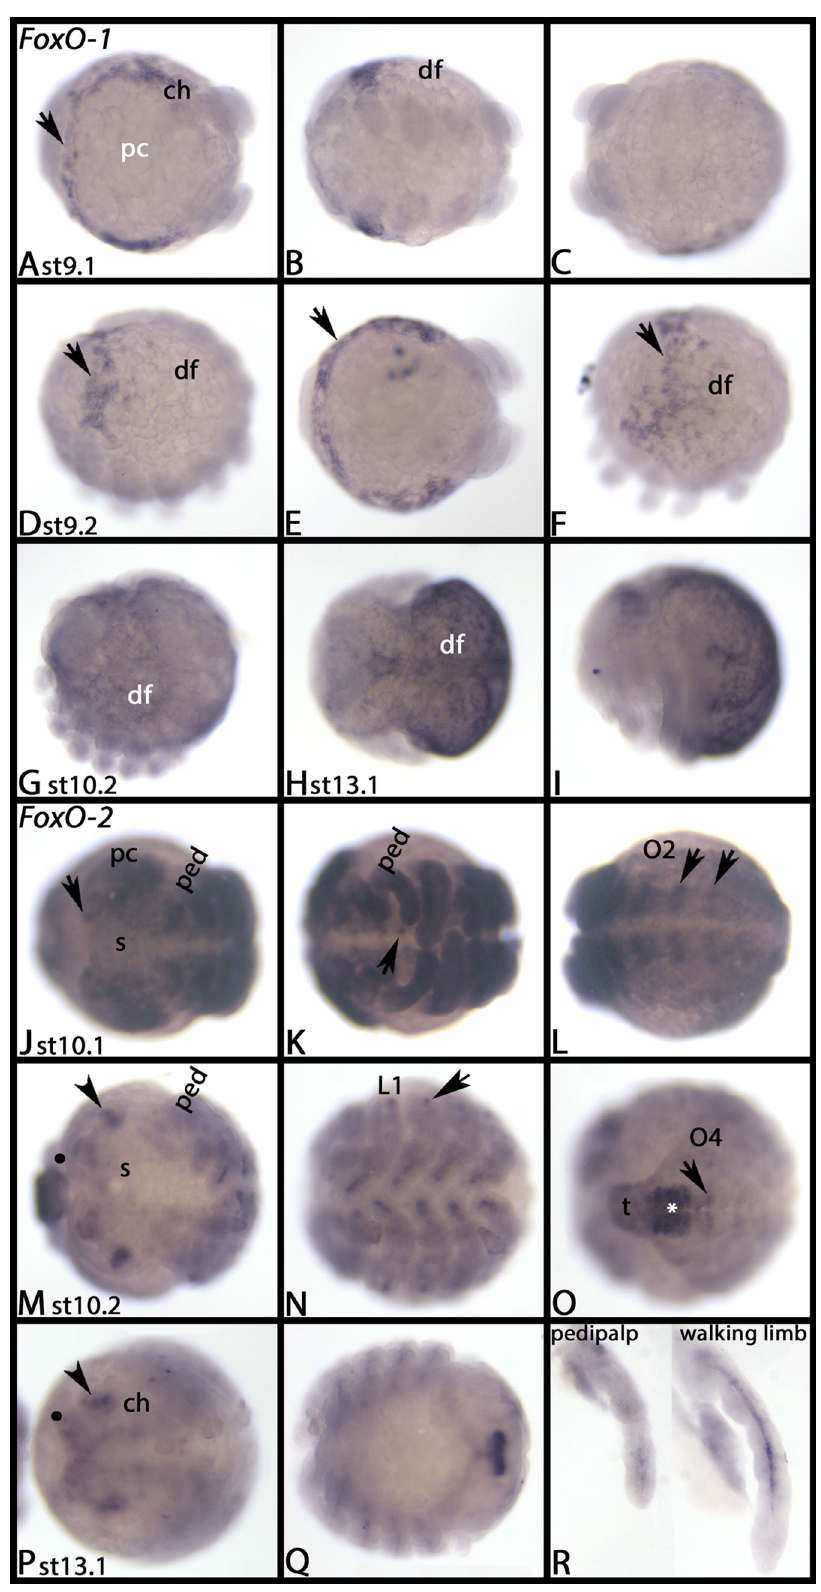
Fig 18. Expression of Parasteatoda FoxO-1 (A-I) and FoxO-2 (J-R). In all panels, anterior is to the left, ventral views, except panels D, F, G, I, and R (lateral views), and H (dorsal view). Each row represents the same embryo,